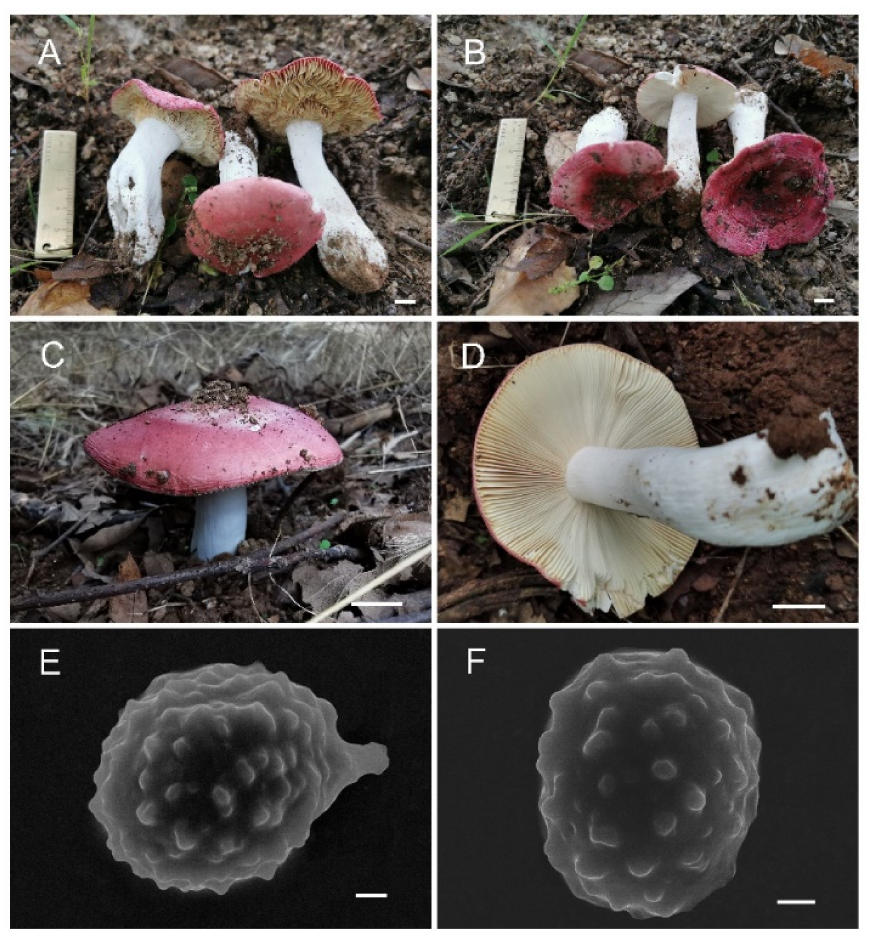
Figure 15. Russula sinorobusta (BJTC Z052). ( A – D ) Basidiomata. ( E , F ) Basidiospores. Scale bar: ( A – D ) = 10 mm, ( E , F ) = 1 µ